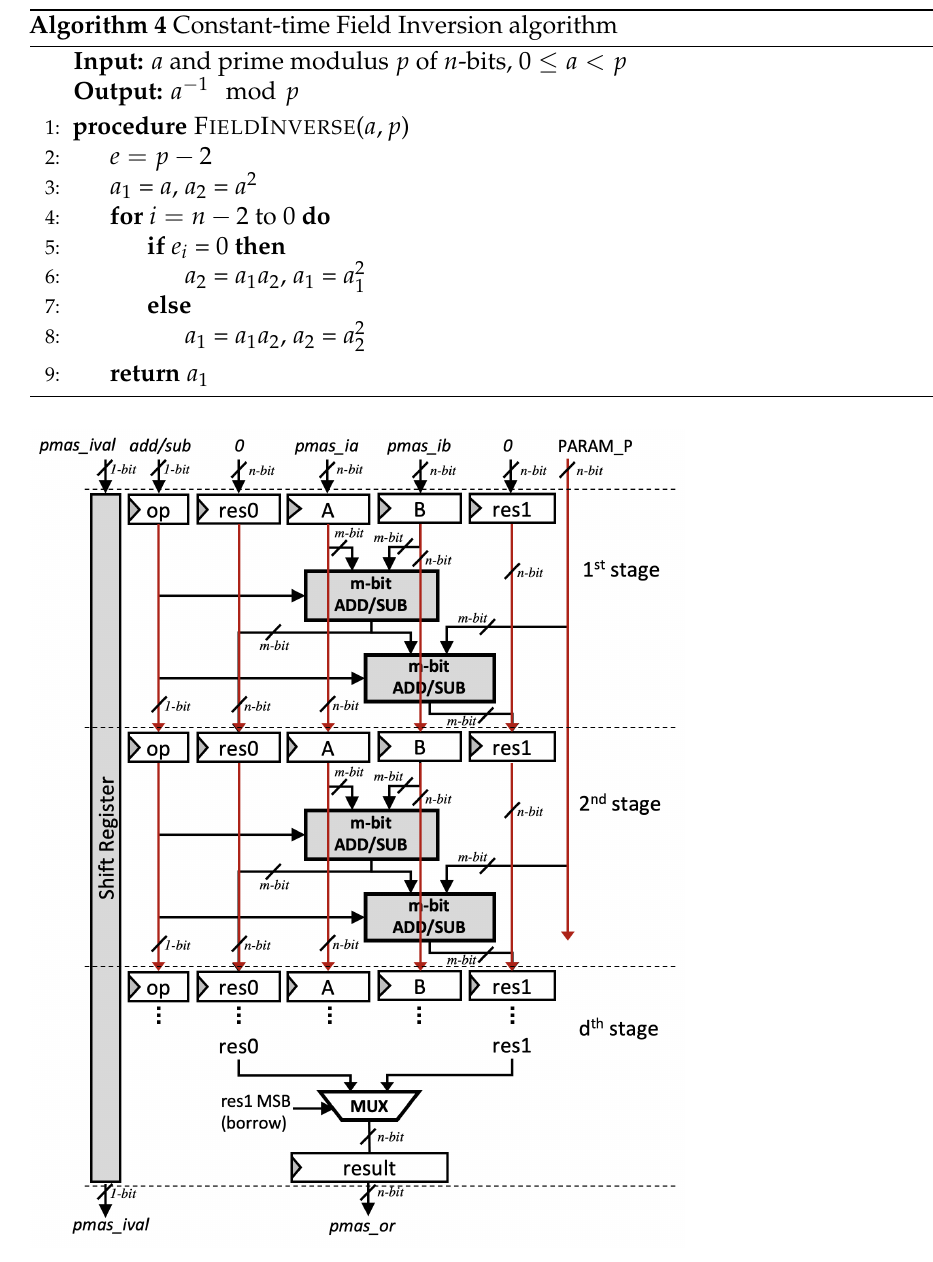
Figure 7. Proposed Modular adder/subtractor